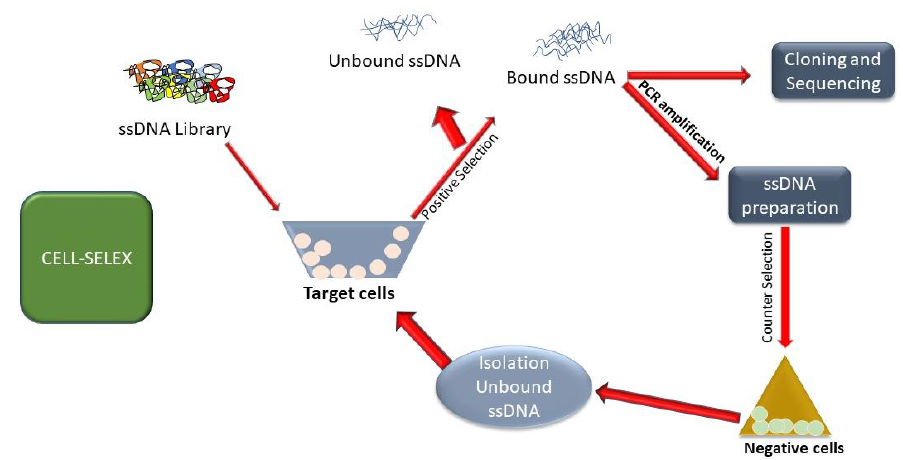
Figure 4. The procedure of Cell-SELEX.